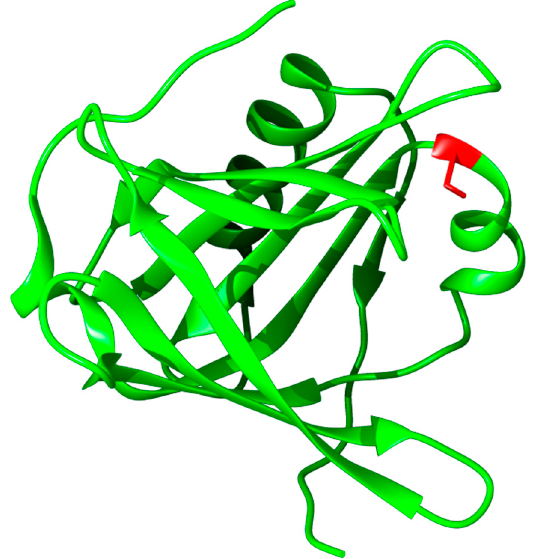
Figure 2. Three-dimensional rendering of A1M based on the published crystal structure [51]. The position of the C34 group (mutated to serine in the crystal structure) is highlighted in red . This is the critical site for the reductase, heme binding, and radical scavenging properties of A1M.